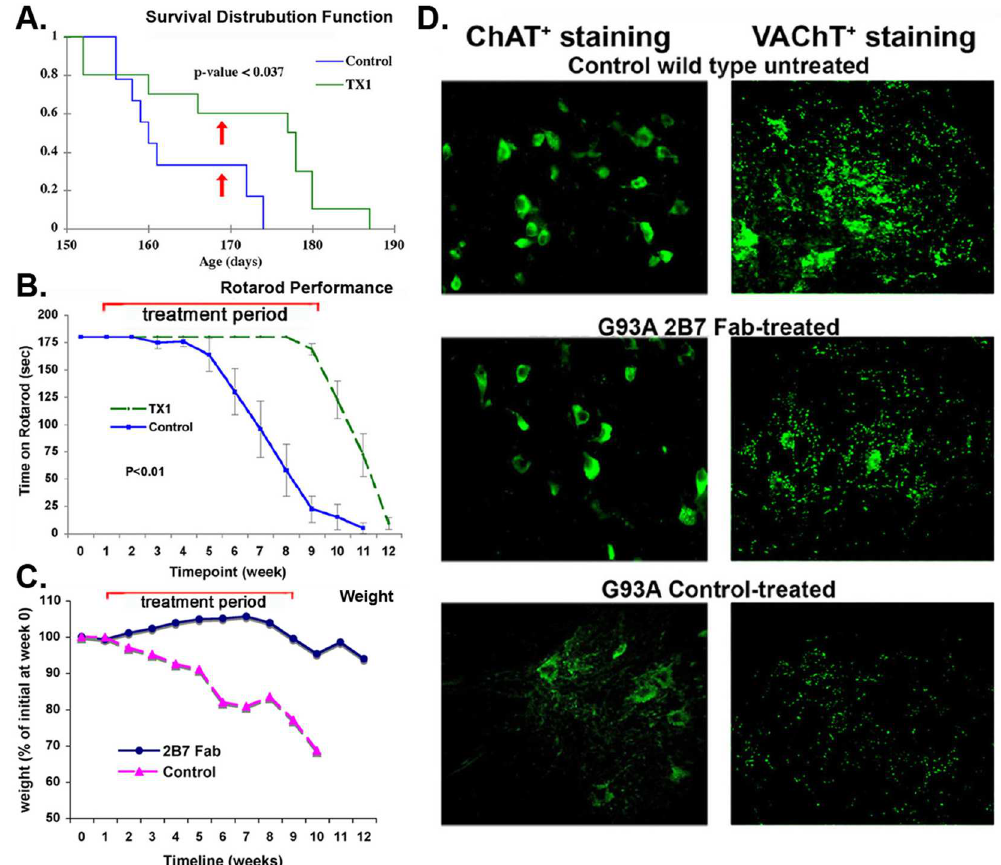
Fig 7. 2B7 Fabs extend life-span and improve motor neuron performanceand phenotype in a mouse model of ALS. In transgenic SOD1 G93A mutant mice, non-binding control Ig or 2B7 Fabs were injected intraperitoneally 3x/week at 0.5 mg/kg (~10 μ g per dose). Treatments were initiated at day ~100 and continued until day ~168. Experiments were done double-blinded, and 2B7 FAb was coded TX1. n = 12 mice per group. The p values in survival and Rotarod Kaplan-Meier plots are derived from log-rank tests.( A ) 2B7 Fab treatment significantly extended life-span, p < 0.037 versus control. The time at which therapy ended is indicated by red arrows. ( B ) 2B7 Fab treatment significantlyimproved Rotarod performance. Shown are 1x per week measurements starting at post-natalday ~100, p < 0.01 versus control. The time-course of drug-treatment is indicatedby the red line. ( C ) 2B7 Fab treatment improved or maintainedbody weight. Shown are 1x per week measurements starting at post-natalday ~100. The time-course of drug-treatment is indicatedby the red line. ( D ) The spinal cords of wild type control, and 2B7-treated or Ig-treated ALS mice were dissected at day 160 (n = 2 per group). Cryosections were studied using fluorescent microscopy after immunostaining with anti-ChAT antibodies (a marker of motor neuron cell body) or anti-VAchT antibodies (a marker of motor neuron cell body and fibers). The ChAT and VAchT phenotypeappearsto be improved in 2B7-treated G93A ALS